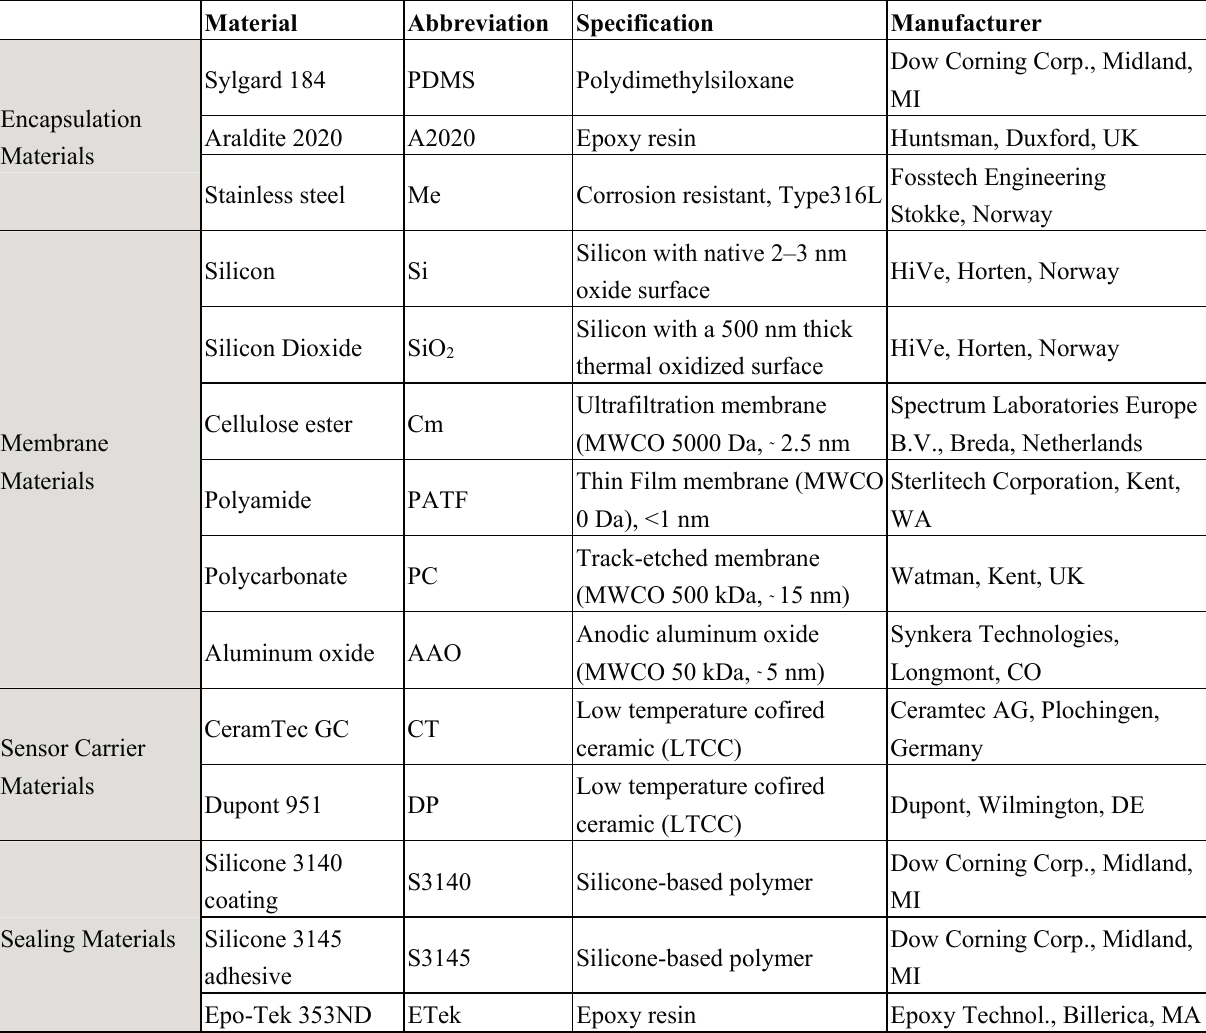
Table 2. Candidate materials for implementation in the glucose sensor